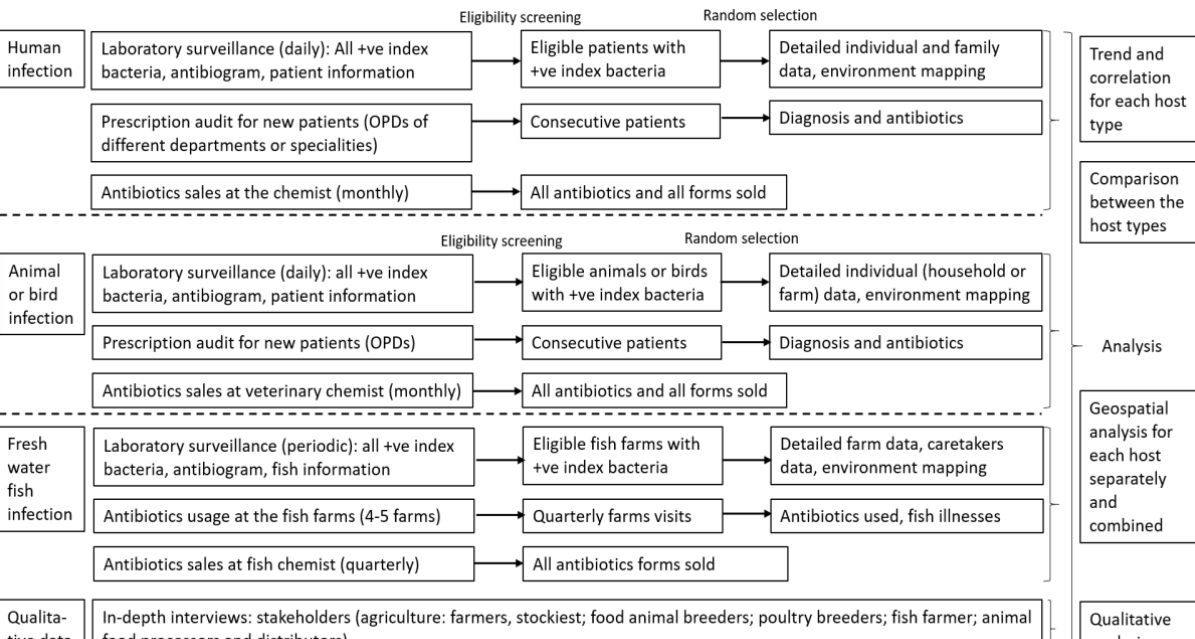
Figure 2. The workflow of surveillance data collection targeted at different hosts. OPDs: outpatient